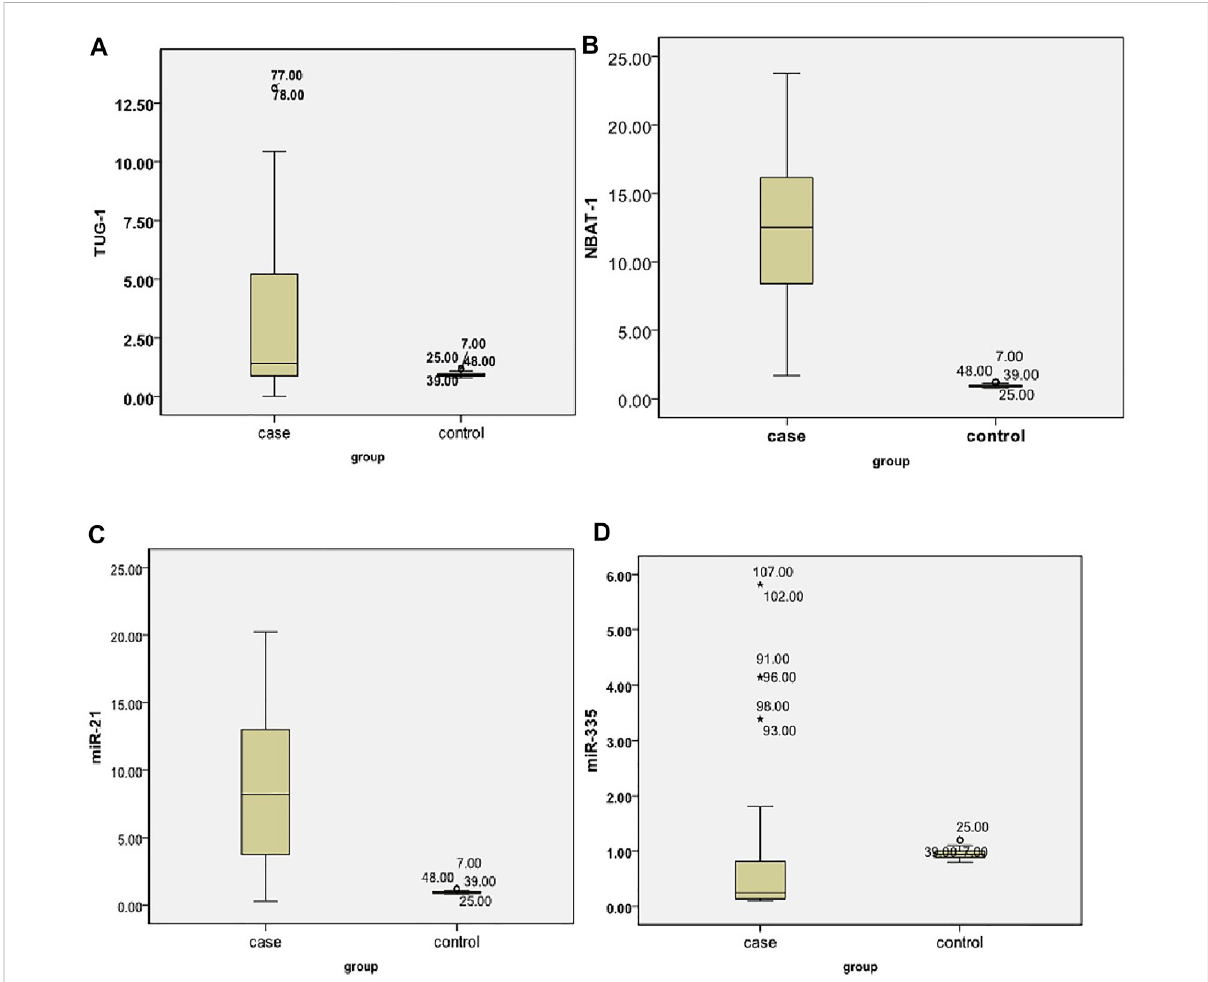
FIGURE 1 Expression levels of different biomarkers among cases (A) A dot plot for TUG1. (B) A dot plot for the NBAT1 levels in the study groups. (C) A dot plot for the miRNA-21 levels. (D) A dot plot for the miRNA-335 levels.